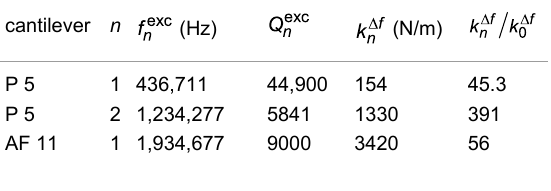
Table 2: Cantilever eigenfrequencies and quality factors of the n th oscillating mode for cantilevers P 5 and AF 11. The modal stiff- ness is obtained from the frequency shift noise spectral density through Equation